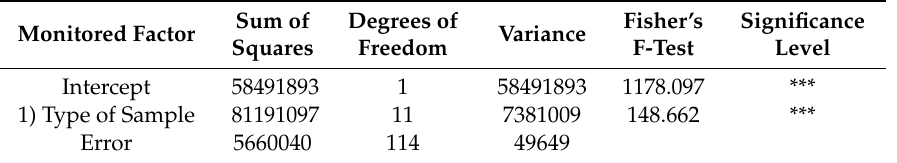
Table 14. Statistical evaluation of the e ff ect of the factors and their interaction on the minimum bend radius at the yield point ( R minC ) for beech and NWC on top.